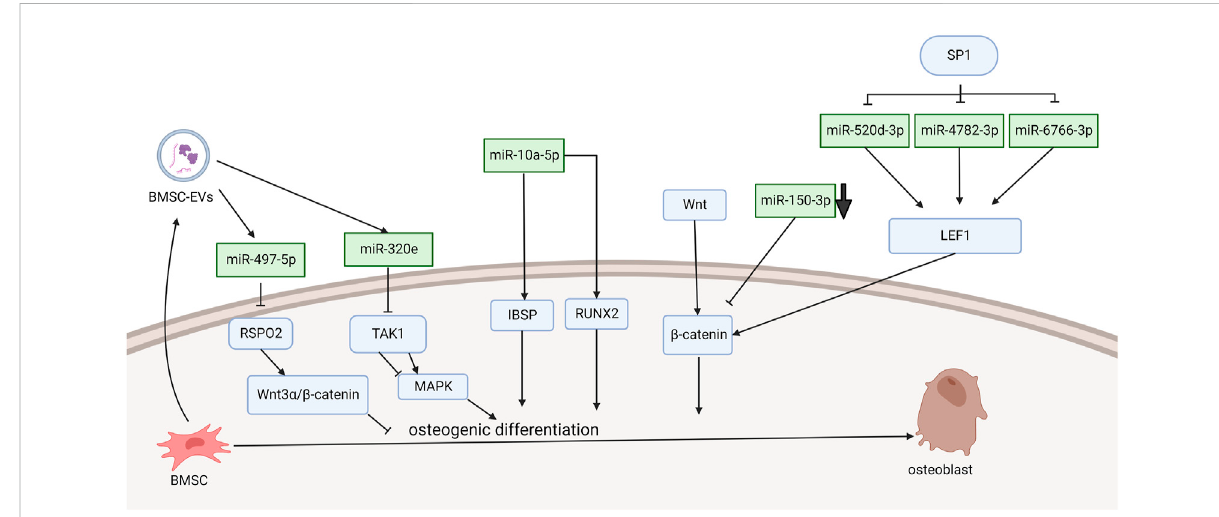
FIGURE 1 Functions of speci fi c ncRNAs in bone marrow mesenchymal stem cells. ( “ Created with BioRender.com ”